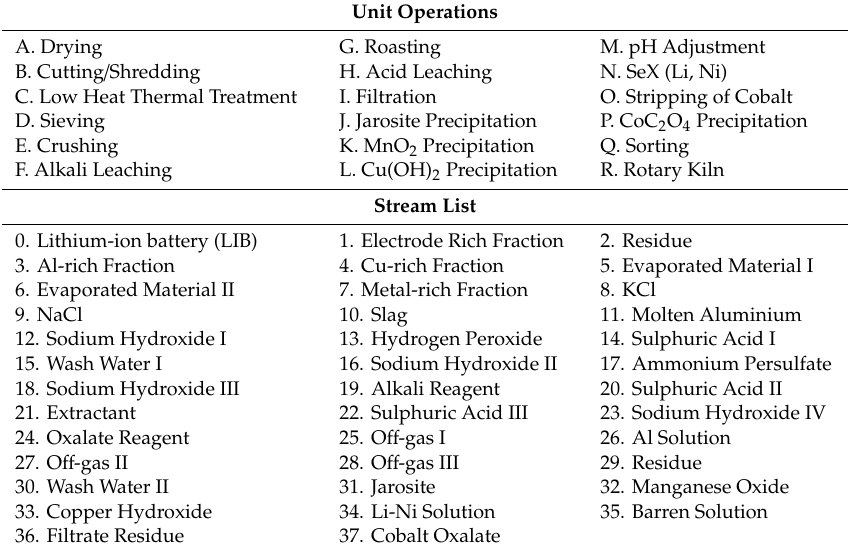
Table 5. List of unit operations, processes, and streams used in node diagrams- Figures 10 and 11.